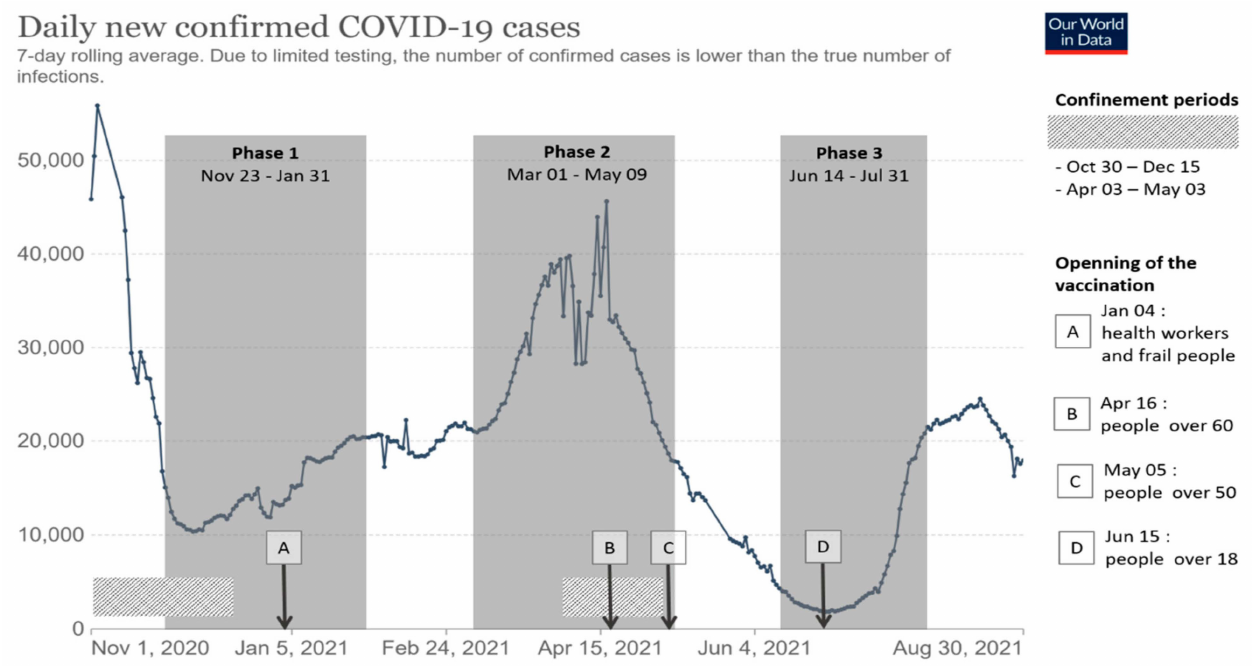
Figure 1. Timeline of the French COVID-19 epidemic during the study